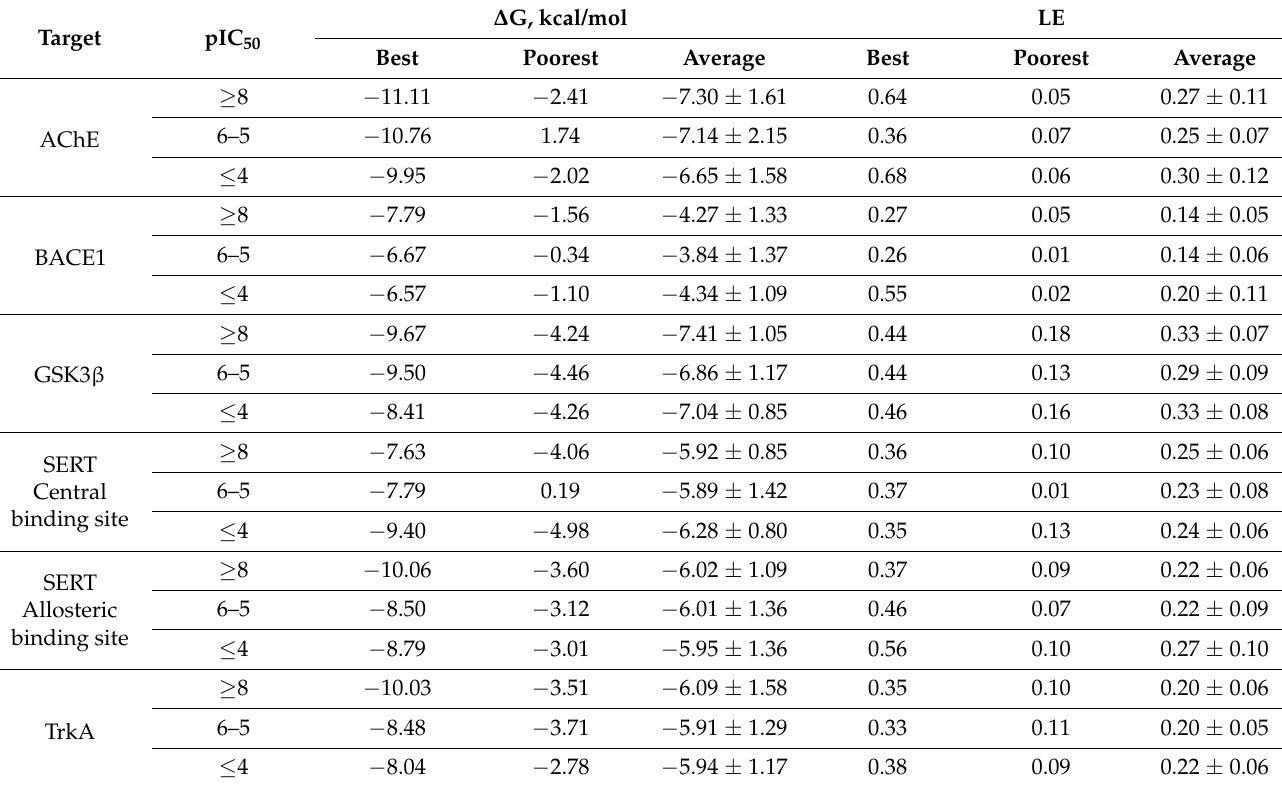
Table 4. The best (lowest binding energy), poorest (highest binding energy) and average values of calculated Glide HTVS binding energies ( ∆ G, kcal/mol) and ligand efficiencies (LE). The average values of binding energies and LEs are presented as mean ±